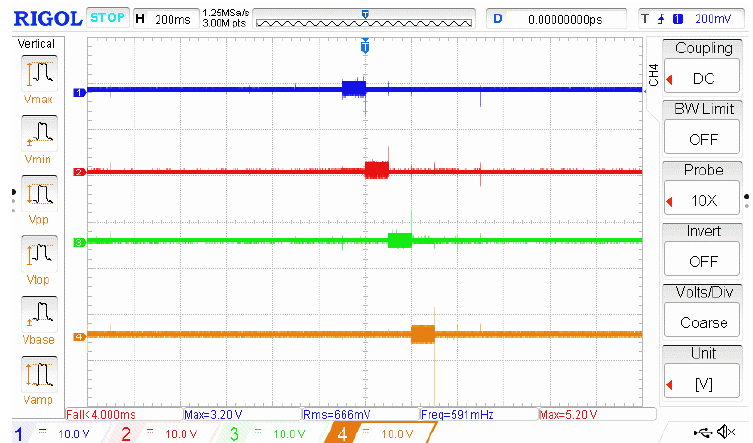
Figure 17. Coils voltages waveform during the scanning phase; blue (CH_1) presents the voltage of coil 4, red (CH_2) presents the voltage of coil 5, green (CH_3) presents the voltage of coil 6 and orange (CH_4) presents the voltage of coil